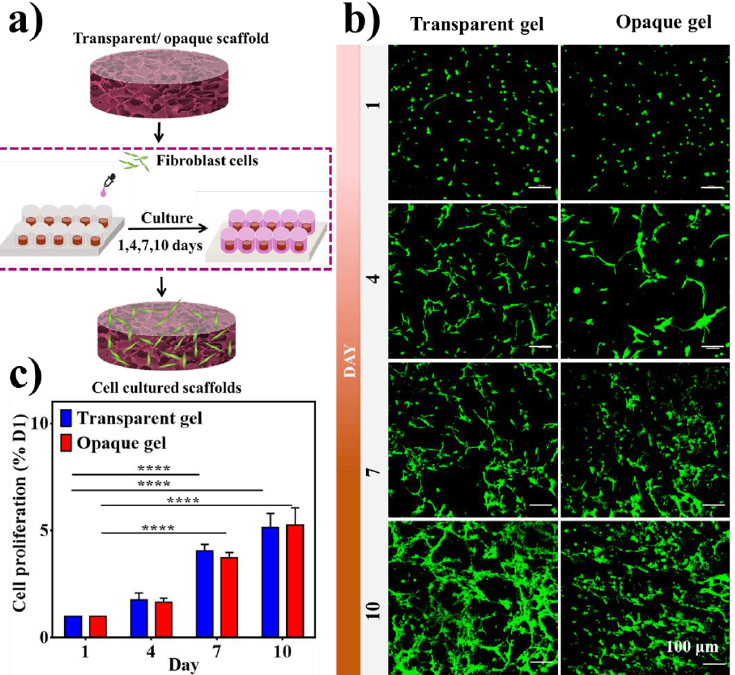
Figure 8. Cytocompatibility of transparent and opaque BSAMA scaffolds (15% ( w / v )). ( a ) Illustration of the cell seeding procedure. ( b ) Live/Dead assay kit was used to assess the cell viability. Calcein AM stained the live cells green and EthD-1 stained the dead cells red. Scale bar = 100 µm. ( c ) CCK-8 test results. (Error bars: ± SD, **** = p < 0.0001, n = 3).